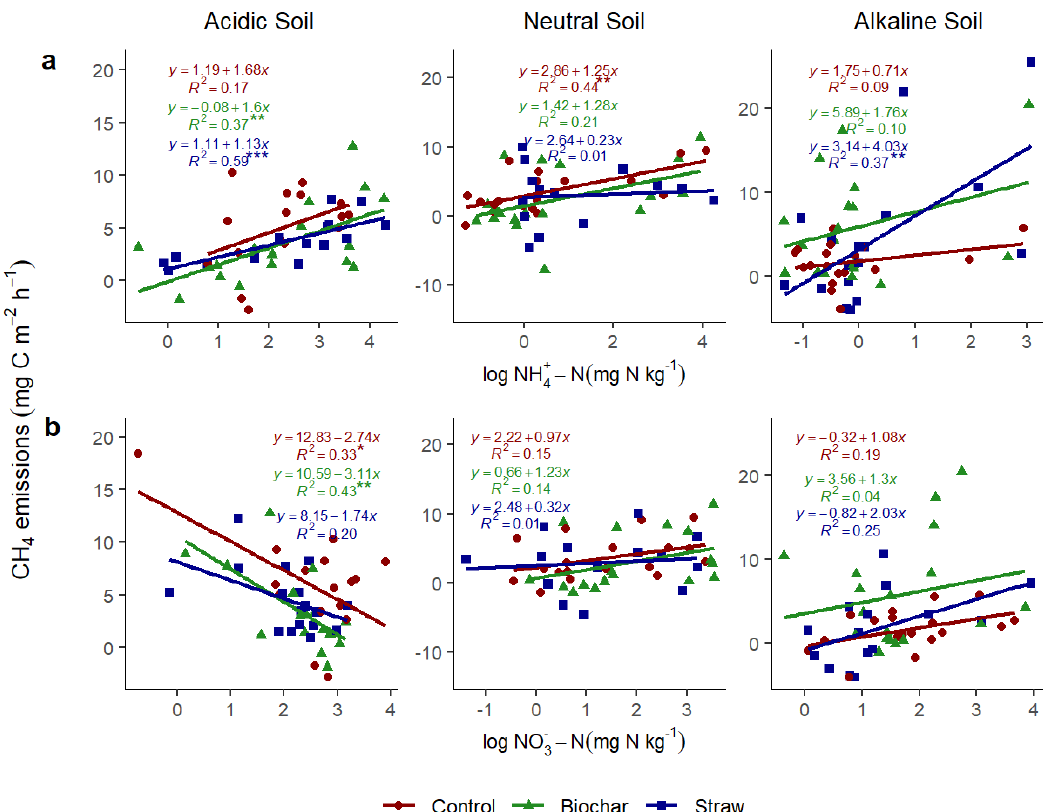
Figure 11. The relationships between CH 4 emissions and ( a ) soil ammonium-N and ( b ) soil nitrate-N in soils of different pH treated with biochar and straw averaged over 18 days. Note: (*) shows that the strength of relationship is significant at p -value ≤ 0.05, (**) shows that the strength of relationship is significant at p -value ≤ 0.01, and (***) shows that the strength of relationship is significant at p -value ≤ 0.001. The axes of different natural soil pH values are on different scales, and the log designation refers to natural